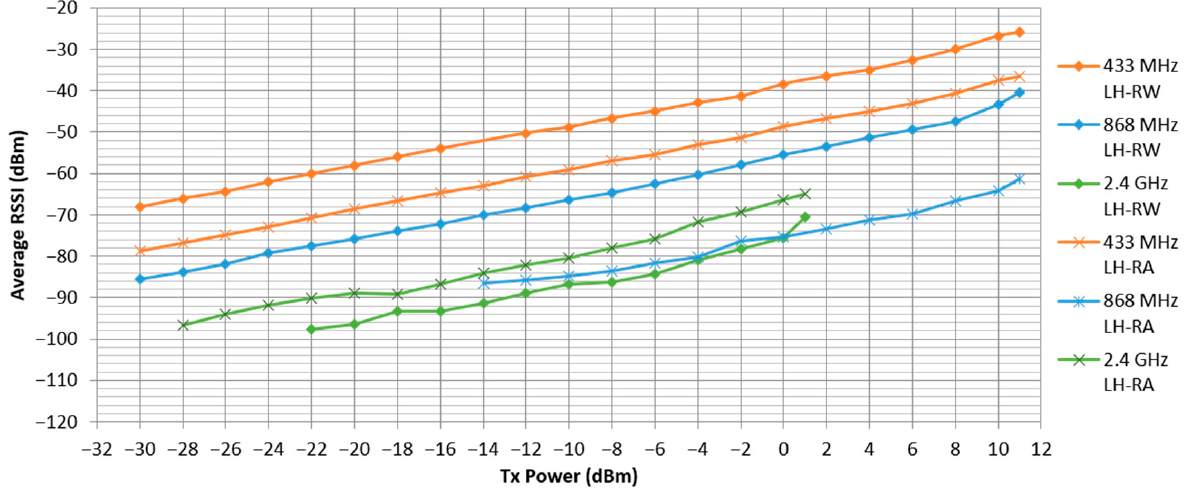
Figure 5. Average receiver signal strength indicator (RSSI) in the standing scenario.